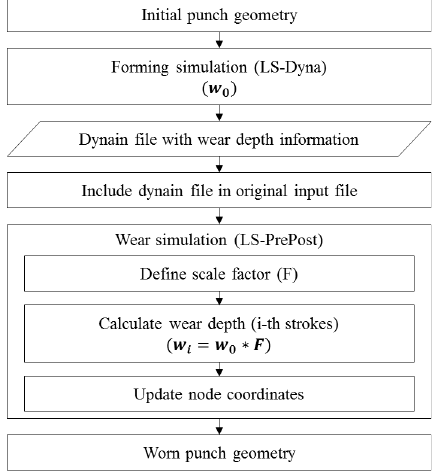
Figure 12. Conventional wear simulation method [37–38,50].